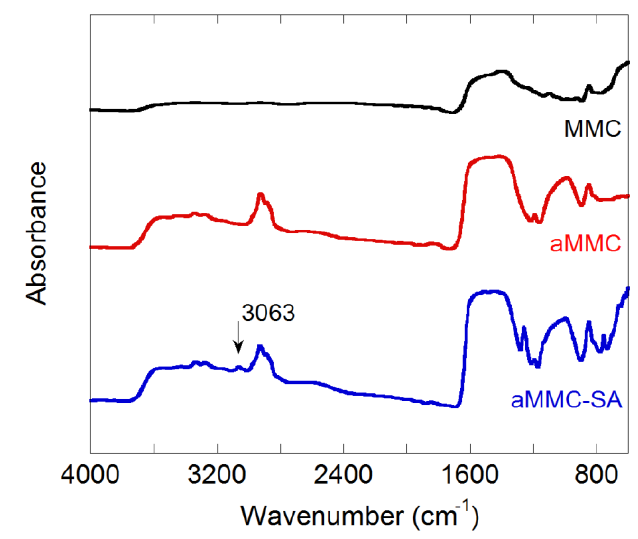
Figure 2. FTIR absorption spectra for the samples under study. Note that the carbonate band at around 1400 cm −1 is saturated on aMMC and aMMC–SA and, therefore, its intensity should not be considered quantitatively.